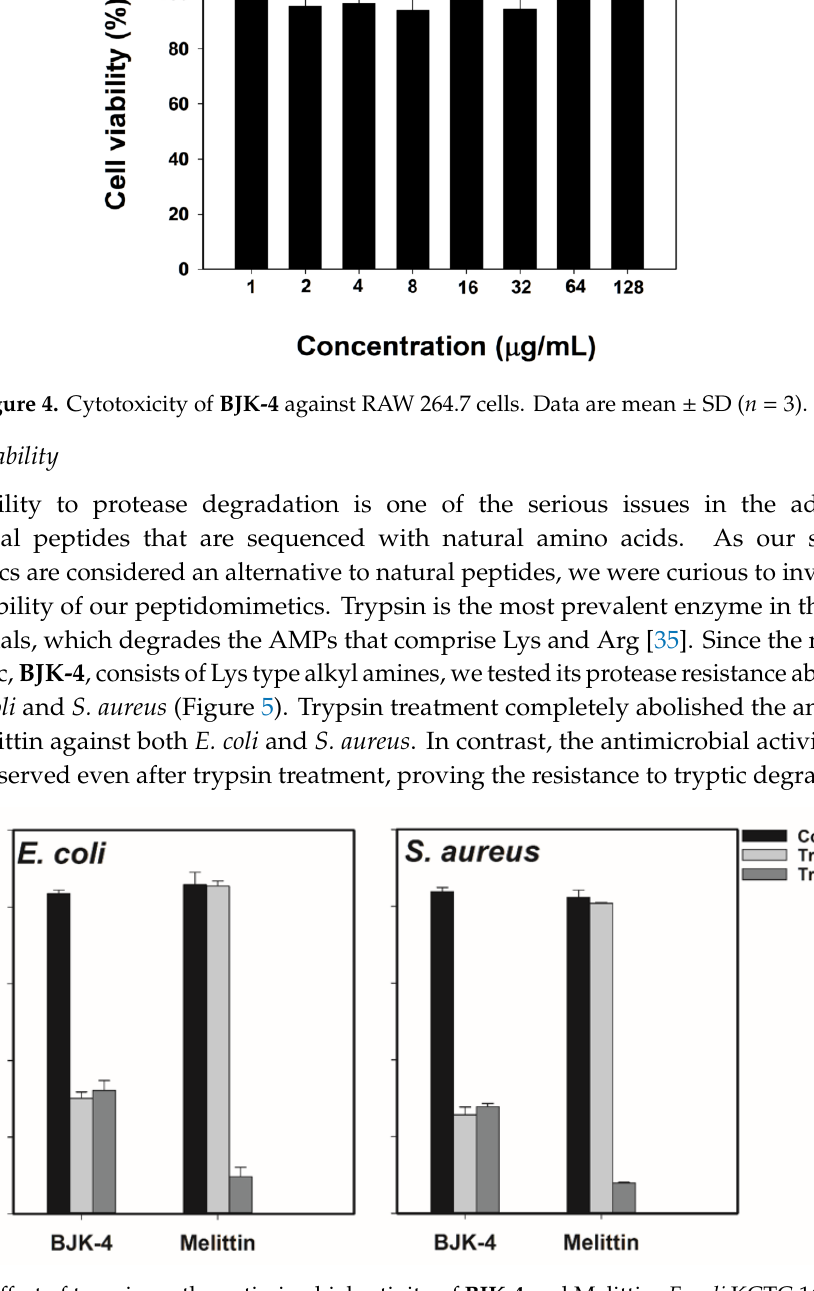
Figure 3. Hemolytic activity of BJK-4 , BJK-(7-10) and melittin against sheep red blood cells (sRBCs).